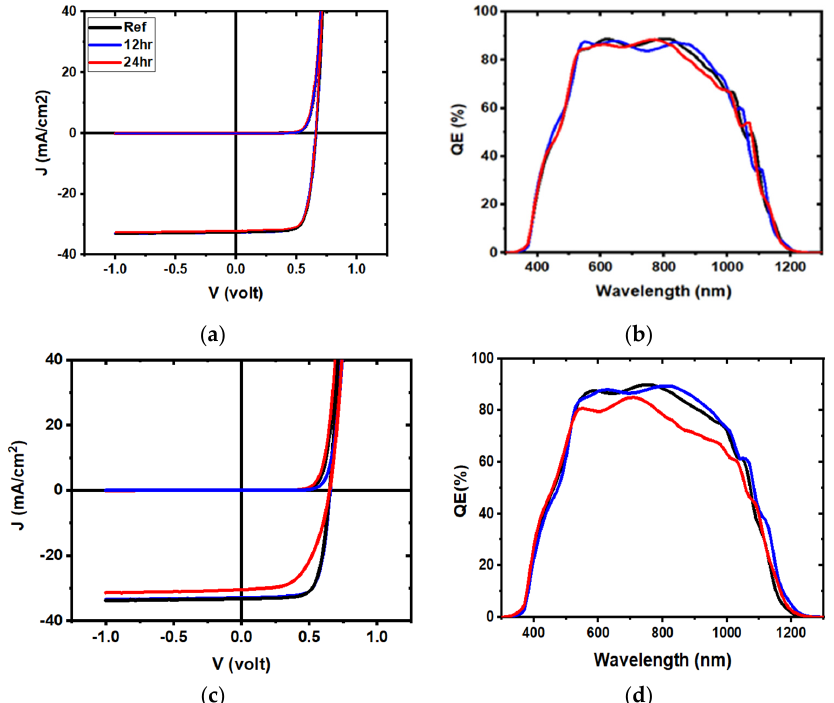
Figure 6. Representative density-voltage (J-V) and quantum e ffi ciency (QE) curves for 3 mTorr samples ( a , b ) and 5 mTorr samples ( c , d ), for reference (black) and water-soaked (12 h: blue, 24 h: red)